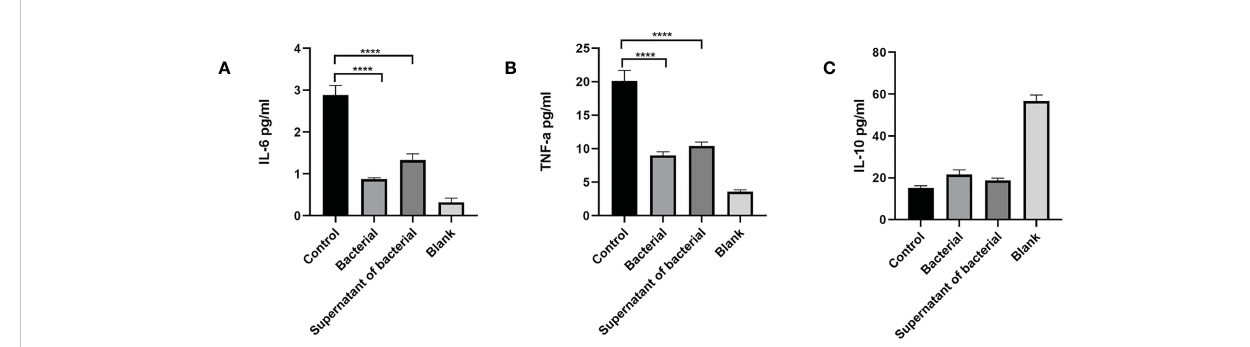
FIGURE 5 CB culture and supernatant inhibit the expression of pro-in fl ammatory cytokines (IL-6,TNF- a ) and promote the expression of anti-in fl ammatory cytokines (IL-10), as shown by ELISA. (A) Serum level of in fl ammatory cytokine IL-6. (B) Serum level of in fl ammatory cytokine TNF- a . (C) Serum level of in fl ammatory cytokine IL-10. Data are presented by mean ± SEM and compared using one-way ANOVA.